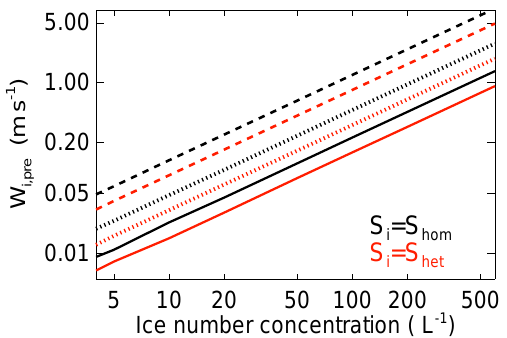
Figure 1. Vertical velocity reduction caused by PREICE ( W i , pre ) as a function of ice number concentration. Results are shown for differ- ent ice radii, 10µm (solid line), 25µm (dotted line) and 50µm (dash line). The ambient condition is that T = − 60 ◦ C, P = 230hpa, S i = S het (red) and S i = S hom (black).